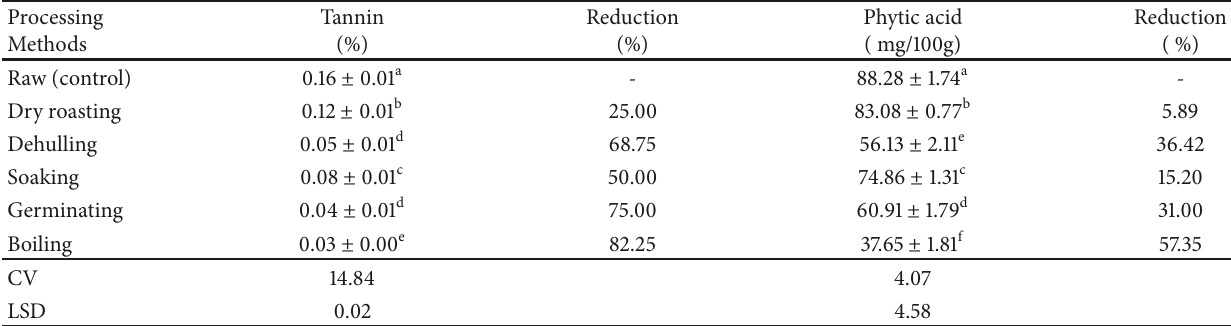
Table 4: Effect of processing methods on the antinutritional